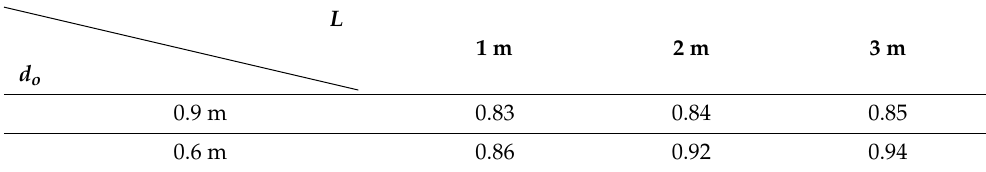
Table 4. Lever arm ( L n,A /h m1 ) for experiments without mitigation